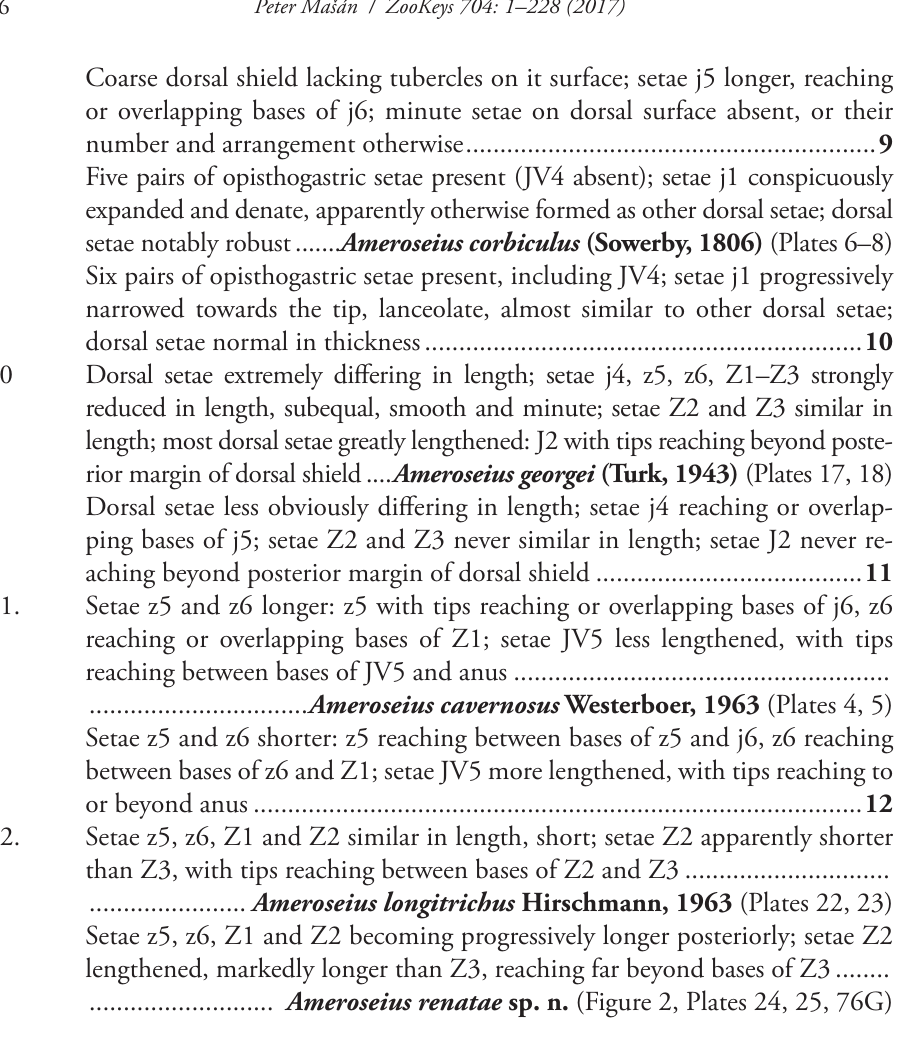
Coarse dorsal shield lacking tubercles on it surface; setae j5 longer, reaching or overlapping bases of j6; minute setae on dorsal surface absent, or their number and arrangement otherwise ............................................................ 9 Five pairs of opisthogastric setae present (JV4 absent); setae j1 conspicuously expanded and denate, apparently otherwise formed as other dorsal setae; dorsal setae notably robust ....... Ameroseius corbiculus (Sowerby, 1806) (Plates 6–8) – Six pairs of opisthogastric setae present, including JV4; setae j1 progressively narrowed towards the tip, lanceolate, almost similar to other dorsal setae; 10 Dorsal setae extremely differing in length; setae j4, z5, z6, Z1–Z3 strongly reduced in length, subequal, smooth and minute; setae Z2 and Z3 similar in length; most dorsal setae greatly lengthened: J2 with tips reaching beyond poste- rior margin of dorsal shield .... Ameroseius georgei (Turk, 1943) (Plates 17, 18) – Dorsal setae less obviously differing in length; setae j4 reaching or overlap- ping bases of j5; setae Z2 and Z3 never similar in length; setae J2 never re- 11. Setae z5 and z6 longer: z5 with tips reaching or overlapping bases of j6, z6 reaching or overlapping bases of Z1; setae JV5 less lengthened, with tips reaching between bases of JV5 and anus ....................................................... – Setae z5 and z6 shorter: z5 reaching between bases of z5 and j6, z6 reaching between bases of z6 and Z1; setae JV5 more lengthened, with tips reaching to 12. Setae z5, z6, Z1 and Z2 similar in length, short; setae Z2 apparently shorter than Z3, with tips reaching between bases of Z2 and Z3 .............................. – Setae z5, z6, Z1 and Z2 becoming progressively longer posteriorly; setae Z2 lengthened, markedly longer than Z3, reaching far beyond bases of Z3 ........